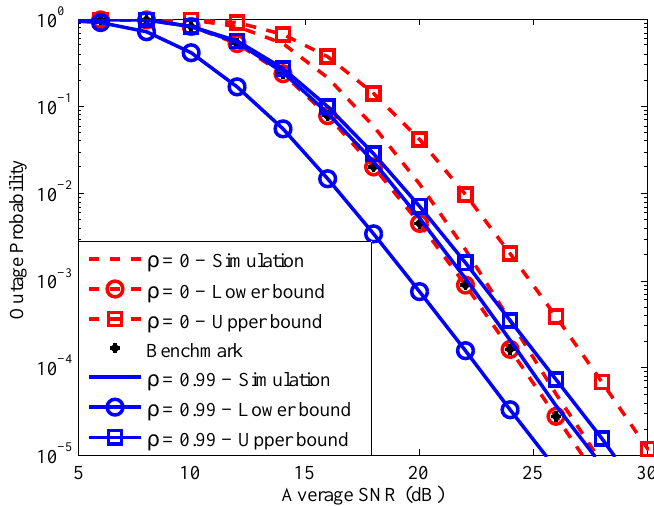
Figure 4. System outage probability versus average received SNR with K = 4.